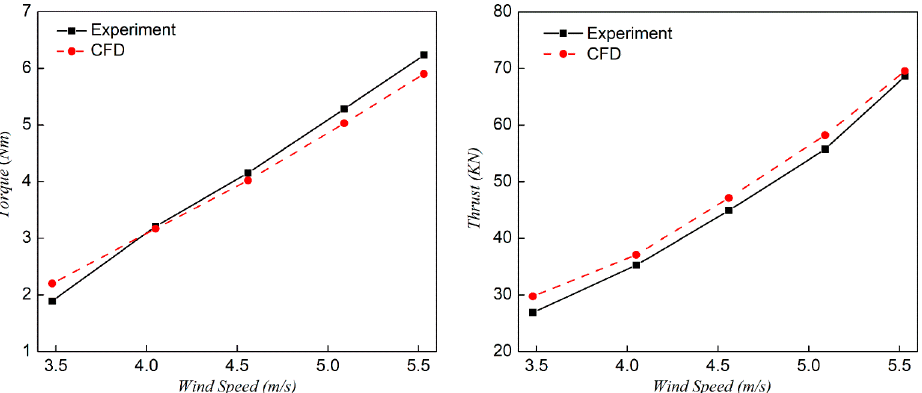
Figure 4. Comparison of thrust and torque between wind tunnel experiment and CFD simulation at different wind speeds (Case 3).